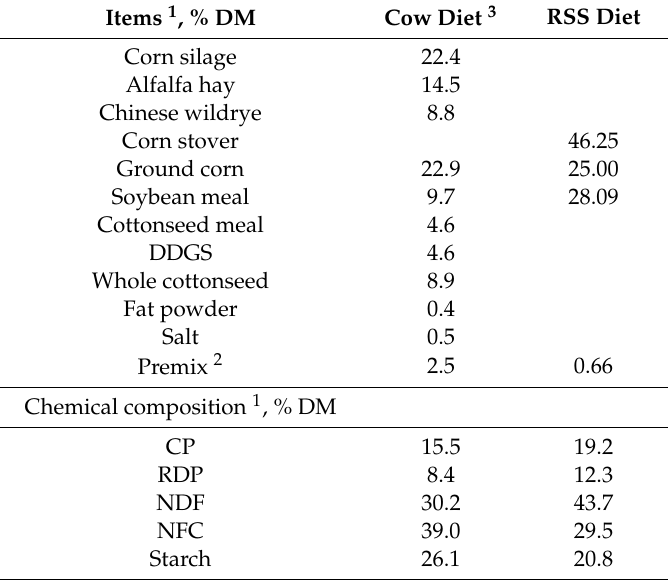
Table 1. Ingredient and nutrient composition of total mixed ration for rumen fluid donated cows and of basic diet for rumen simulation system (RSS).